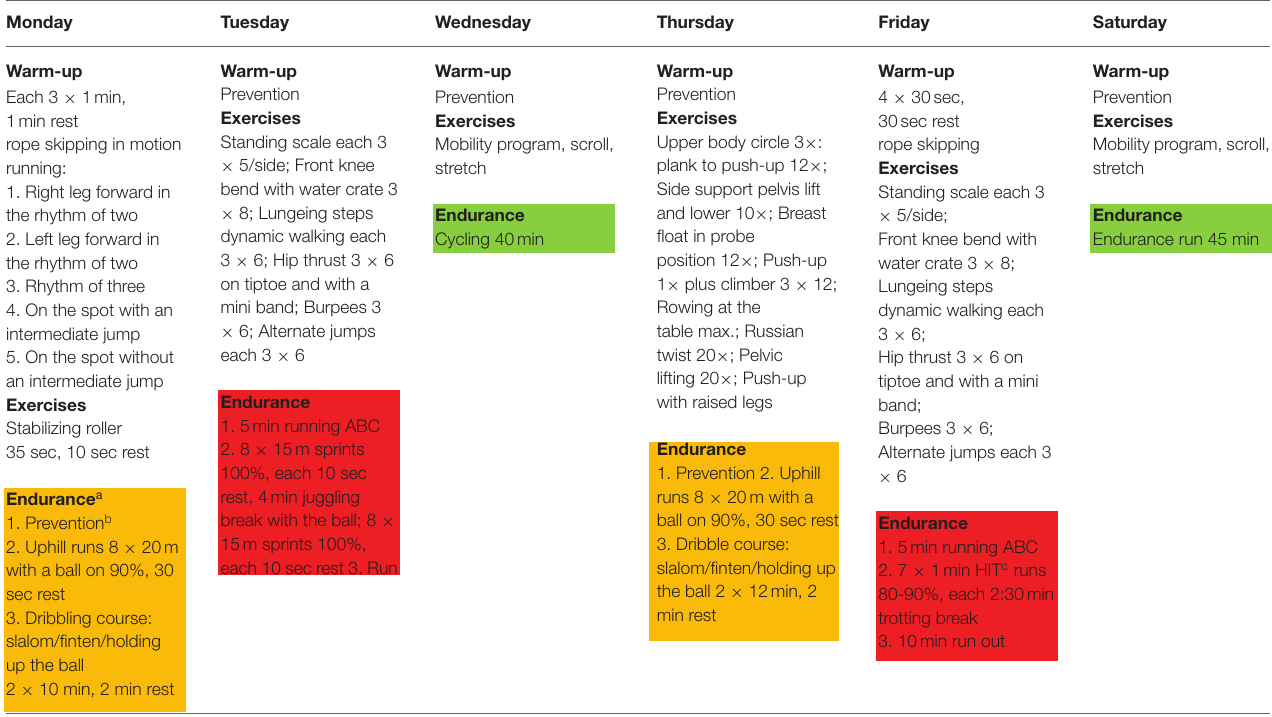
TABLE 1 | An example of a typical home training schedule of professional youth soccer players during the COVID-19 lockdown.